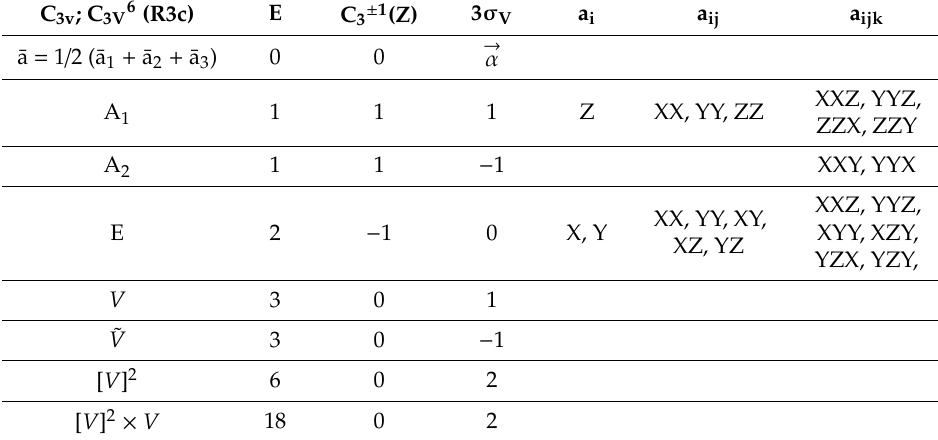
Table 1. Character of a point group representations; ¯a = 1 / 2 (¯a 1 + ¯a 2 + ¯a 3 )—avector of partial translation of a space group C 3V6 (R3c); a i , a ij are the components of a vector and a symmetric second-rank tensor, respectively; a ijk is a third-rank tensor symmetric with respect to the first two indices. They are transformed by the corresponding irreducible representations of the C 3V